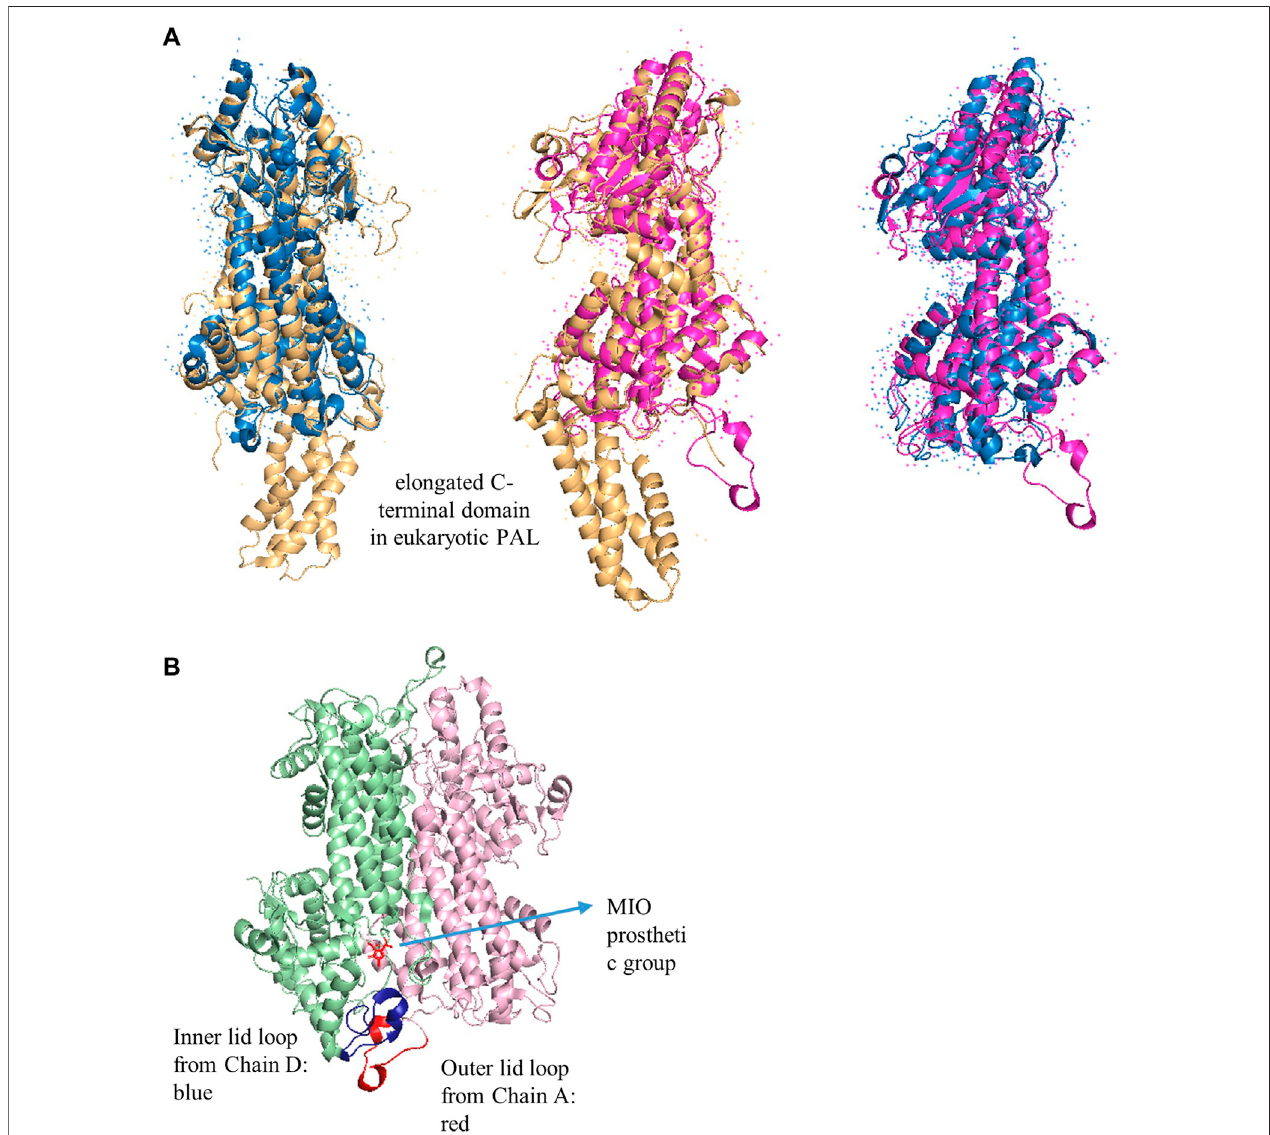
FIGURE 6 | (A) Overlap X-ray crystal structures of PpHAL from Pseudomonasputida (PDB entry 1GKM, blue), RtPAL from R.toruloides (PDB entry 1T6J, yellow), and RsTAL from Rhodobacter sphaeroides (PDB entry 2O6Y, pink) (B) The inner (blue) and outer (red) loops in RsTAL from two chains. The MIO is colored in red.